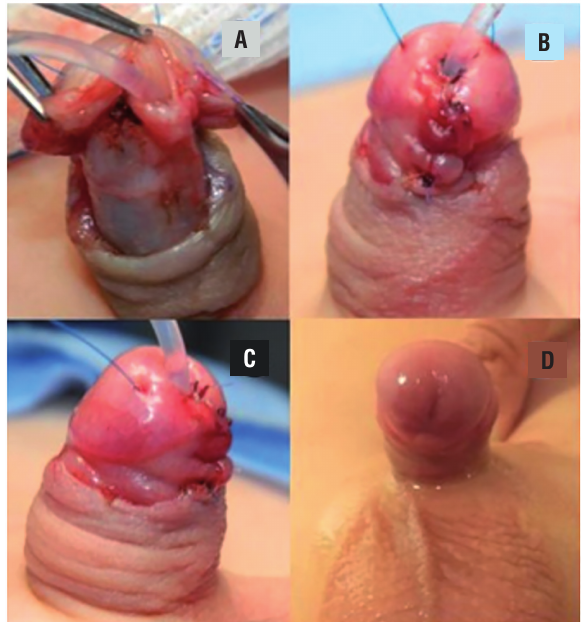
Figure 2 - GUD technique: final